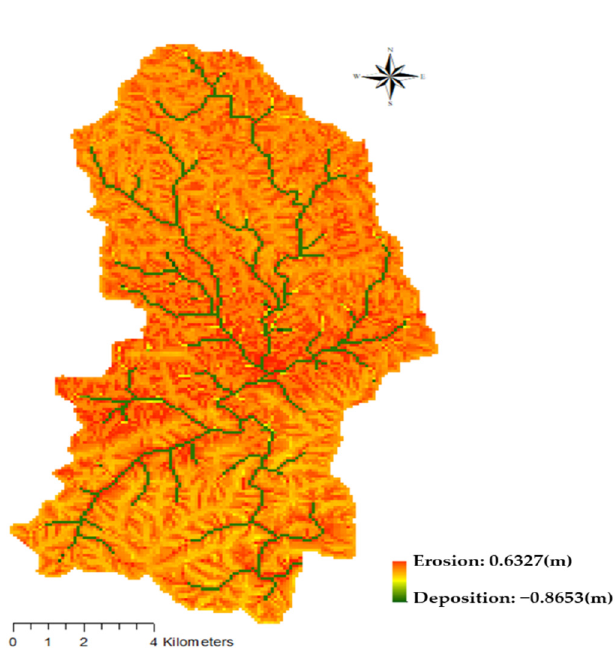
Figure 7. Spatial distribution of net erosion by the R-SSEM.